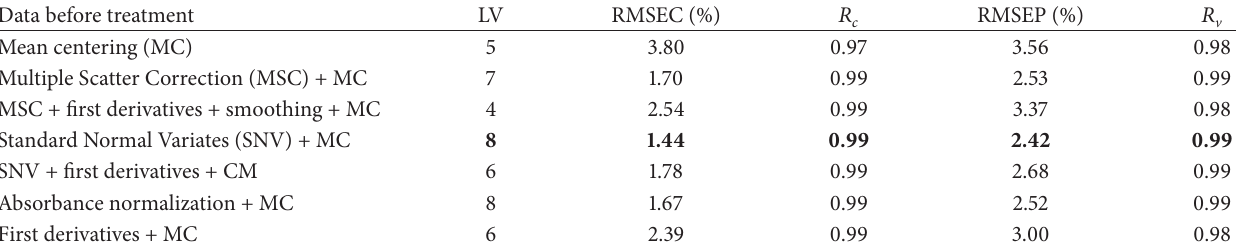
Table 2: Performance results of full-spectrum PLS models based on different data preprocessing techniques.